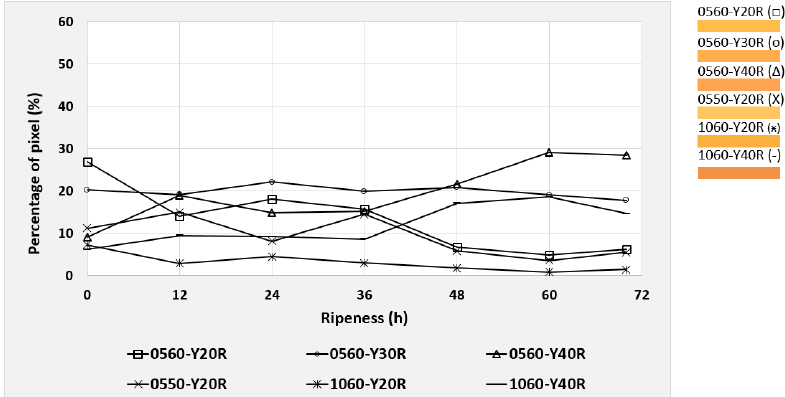
Figure 10. Development of the six most dominating pulp colors of cv. “Nam Dokmai” mangos during the 70 h post-ripening process, represented as NCS color codes.